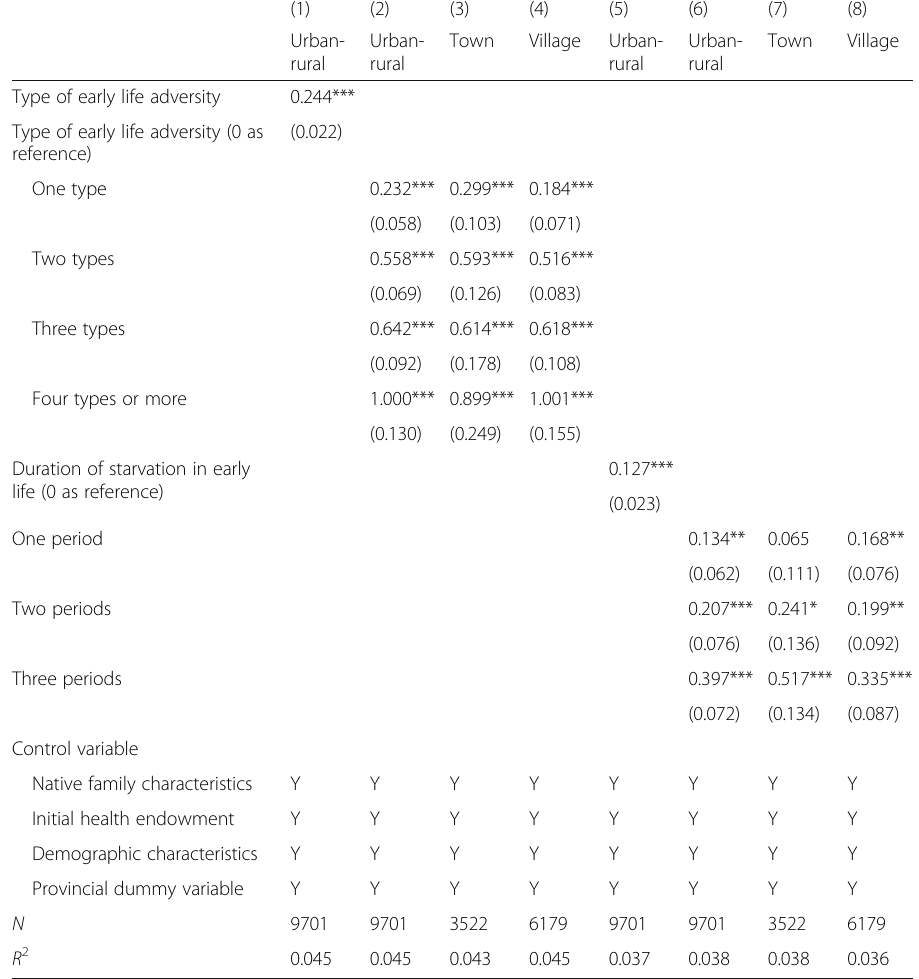
Table 2 Estimated effects of the type and duration of early life adversity on